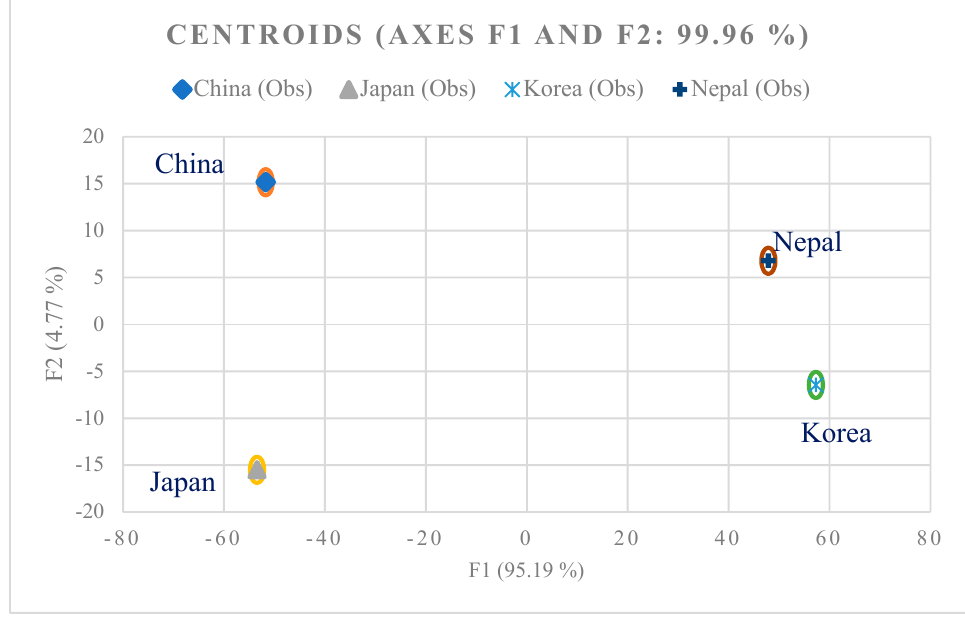
Figure 5. LDA map of geographical origin based on heavy metal content. The confusion matrix, calculated for the training samples based on heavy metals for all four observed geographical groups, equals 100%, meaning that all training samples were identified correctly using LDA (data not shown). Furthermore, LDA calculates mem- bership probabilities for unknown samples using the Cross-validation: Prior and posterior classification, and membership probabilities (Table 7). Our results proved that LDA using heavy metal content correctly authenticated the origin of teas from Japan, China, and Ne- pal but did not identify the origin of Korean samples. These samples were misidentified as Nepal and Japan tea samples, respectively. Given that the prior and posteriors classifi- cation showed two misclassified samples (Table 7), the confusion matrix for the cross- validation was lowered by 25% to the total accuracy of the LDA model of 75% (Table 8). Table 7. Cross-validation: Prior and posterior classification, membership probabilities, scores, and squared distances. Observation